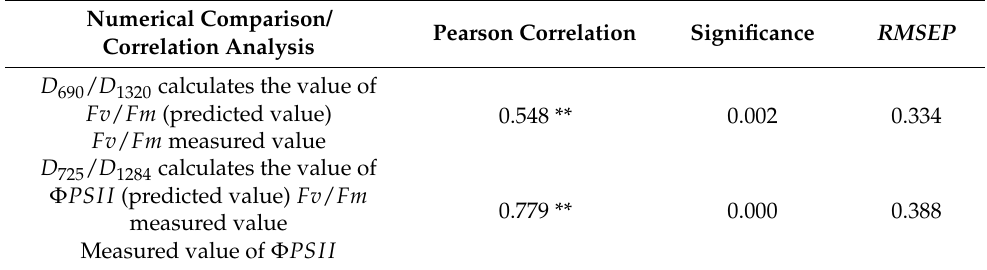
Table 3. Validation of chlorophyll fluorescence parameters Fv / Fm and Φ PSII model for hyperspec- tral vegetation